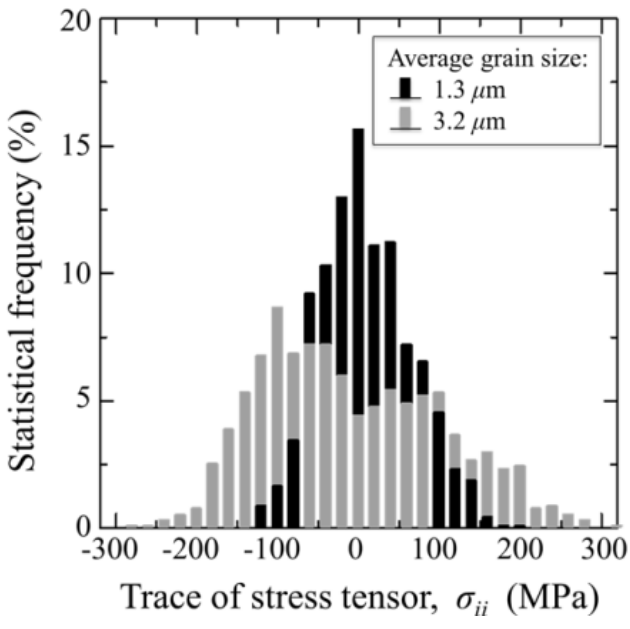
Figure 5. Average stress histograms collected on statistically meaningful surface areas of O materials belonging to two different generations of Al unused biomedical Al 2 3 bioceramics for hip joints. The average grain sizes are shown in